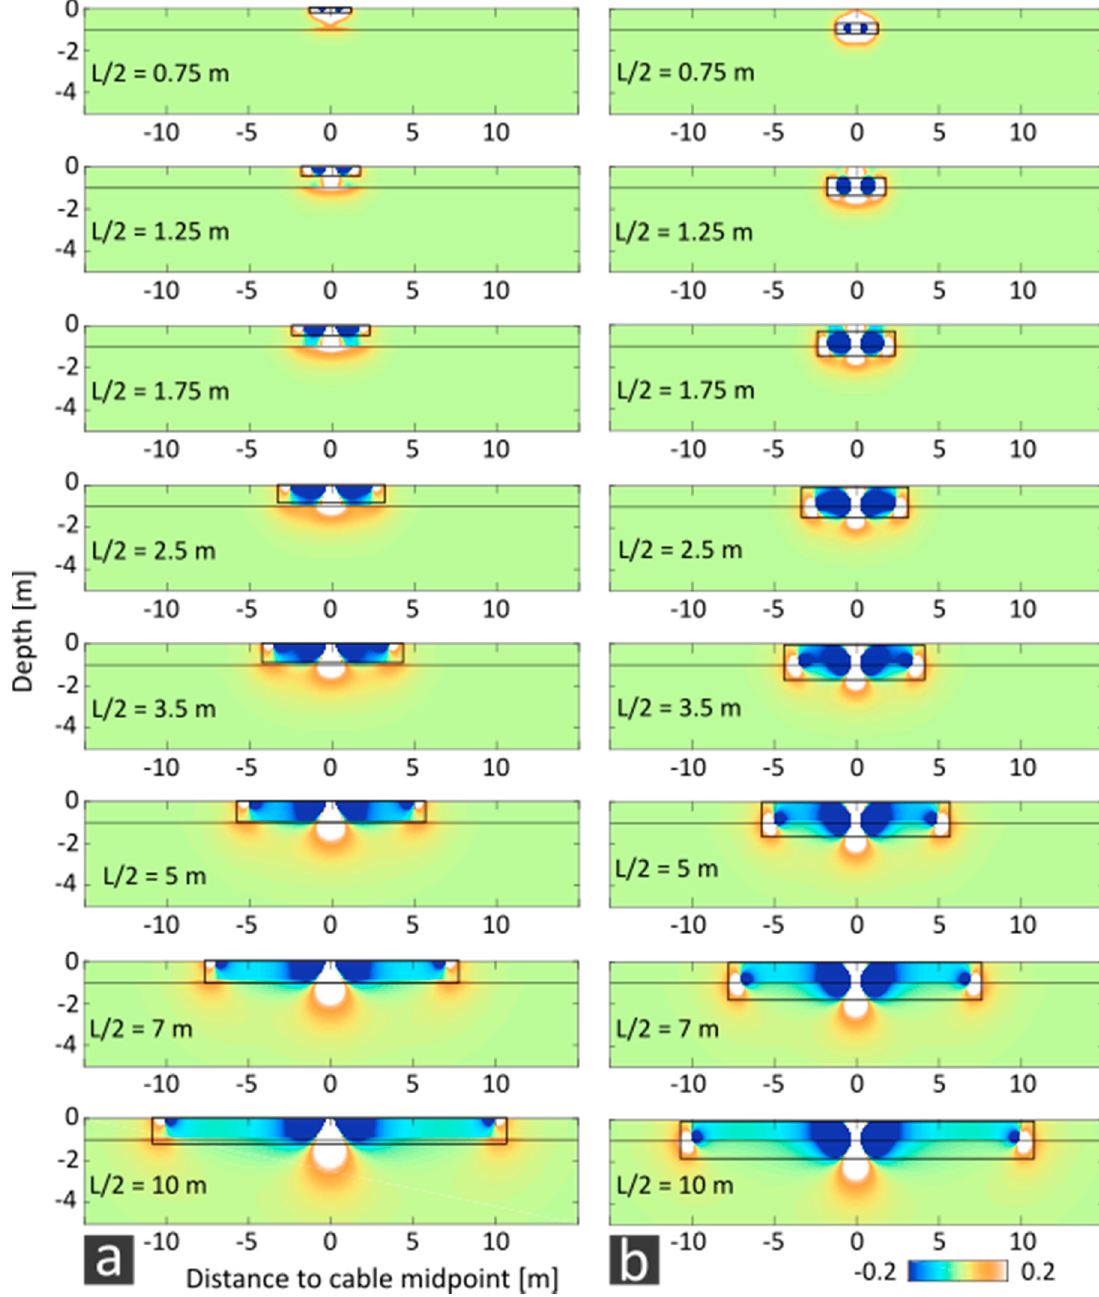
Figure 14. Comparison of sensitivity kernels from the inverse Schlumberger array used for repetition measurements in Eckernförde Bay, Germany, consisting of eight electrode pairs (Table 1). ( a ) setup F and ( b ) setup S are compared, and the lateral highly sensitive area is framed in black.